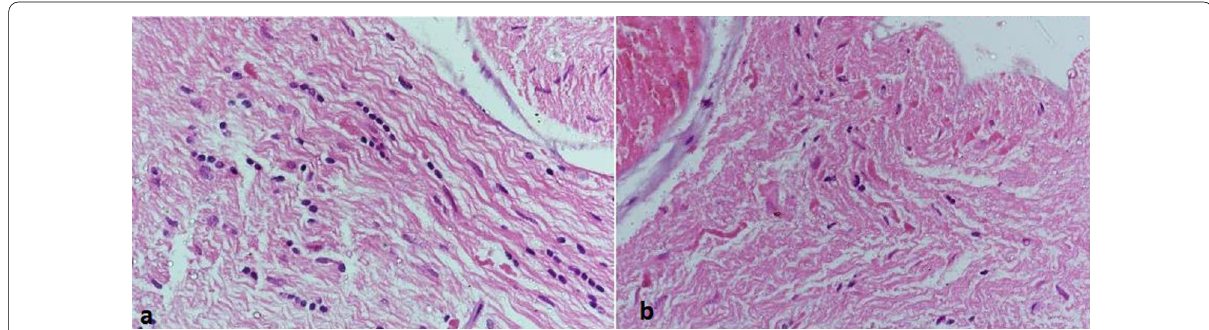
Fig. 2 a High power photomicrograph showing a low grade glial tumor with focal increase in cellularity and cells arranged in Indian file pattern ( 400). b Another photograph (below) showing Rosenthal fibers and eosinophilic granular bodies ( ×